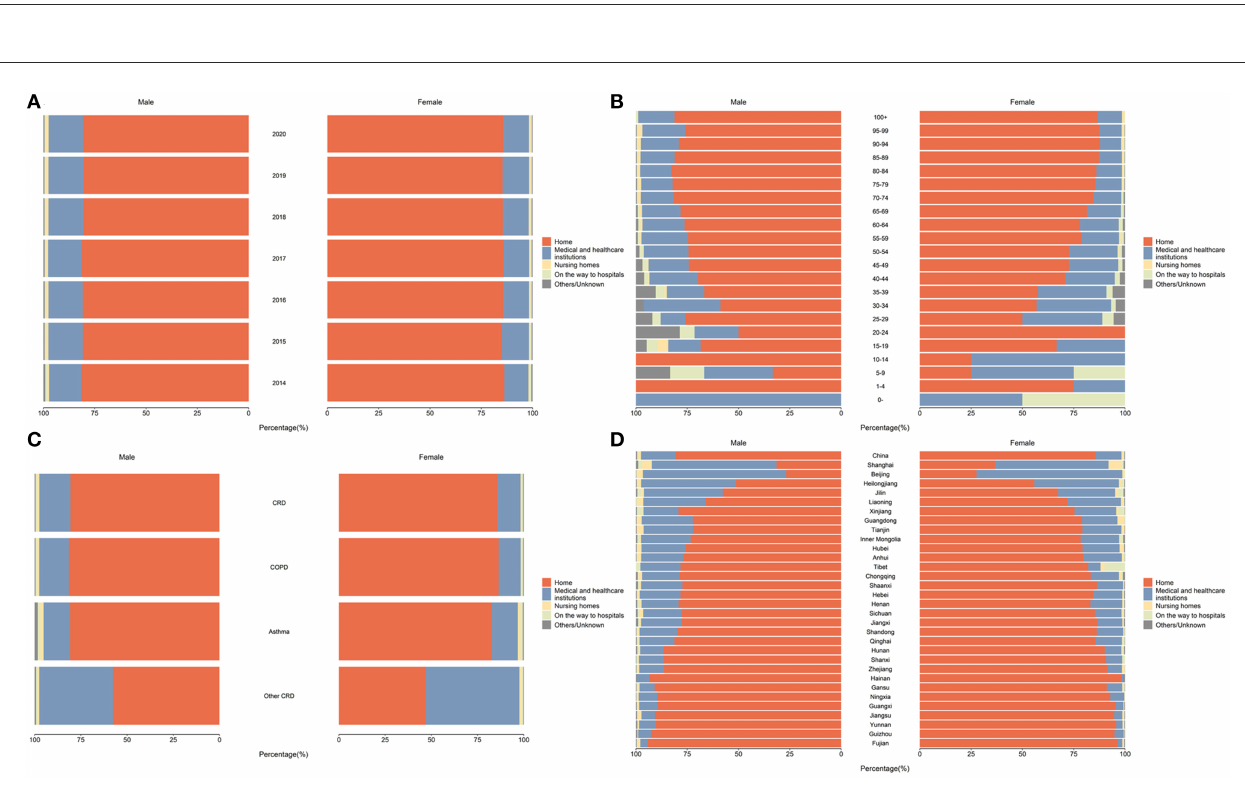
FIGURE2 The distribution of POD among CRD deaths in China, by sex (%). (A) Distribution of POD among CRD deaths in China, 2014–2020; (B) Distribution of POD among CRD deaths in China, by age, 2020; (C) Distribution of POD among CRD deaths in China, by CRD subcategories, 2020; (D) Distribution of POD among CRD deaths in China, by province,